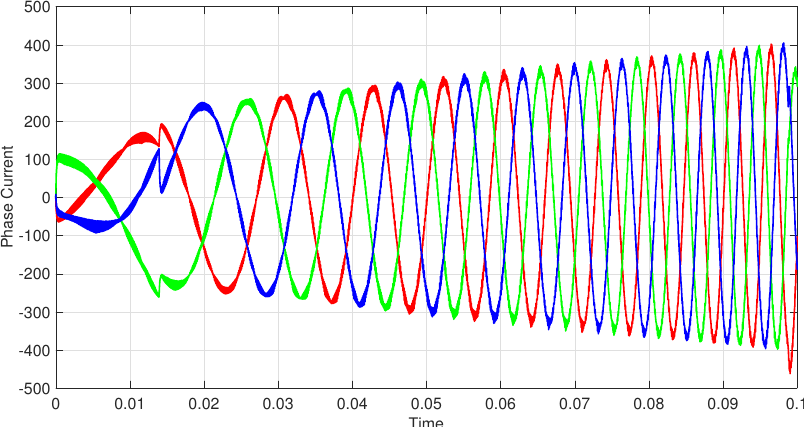
Figure 14. Three-phase output current waveforms under VVVF control. Total harmonic distortion (THD) is a waveform’s distortion factor, which is defined as the ratio of the effective (rms) value of harmonic components to its counterpart of the fundamental component. In other words, THD is the degree of relatedness of the output waveform shape to its fundamental component. On the other hand, fast Fourier